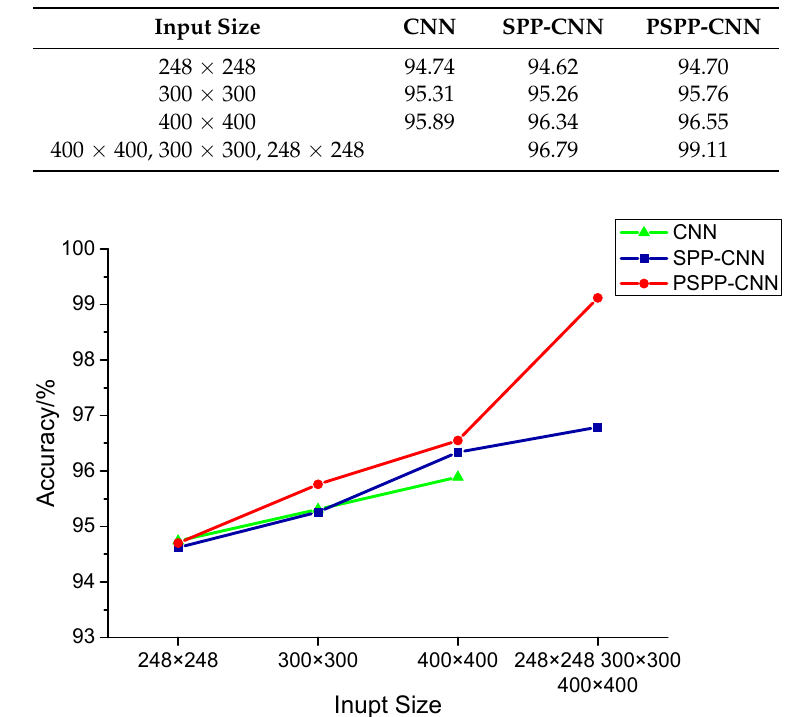
Table 8. Accuracy of test samples using different CNN models.